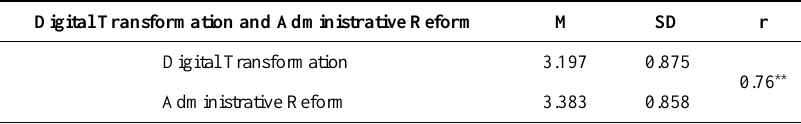
Table 10. Correlation between Digital Transformation and Administrative Reform Digital Transformation and Administrative